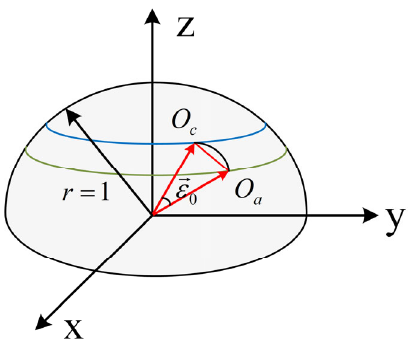
Figure 6. The calculation model of the TOT contour